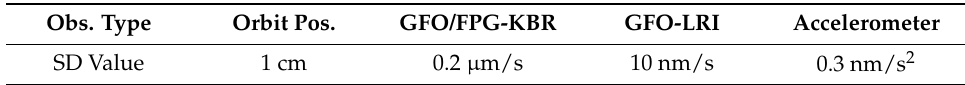
Table 3. The standard deviations (SD) of white Gaussian sensor noises used for the generation of simulated